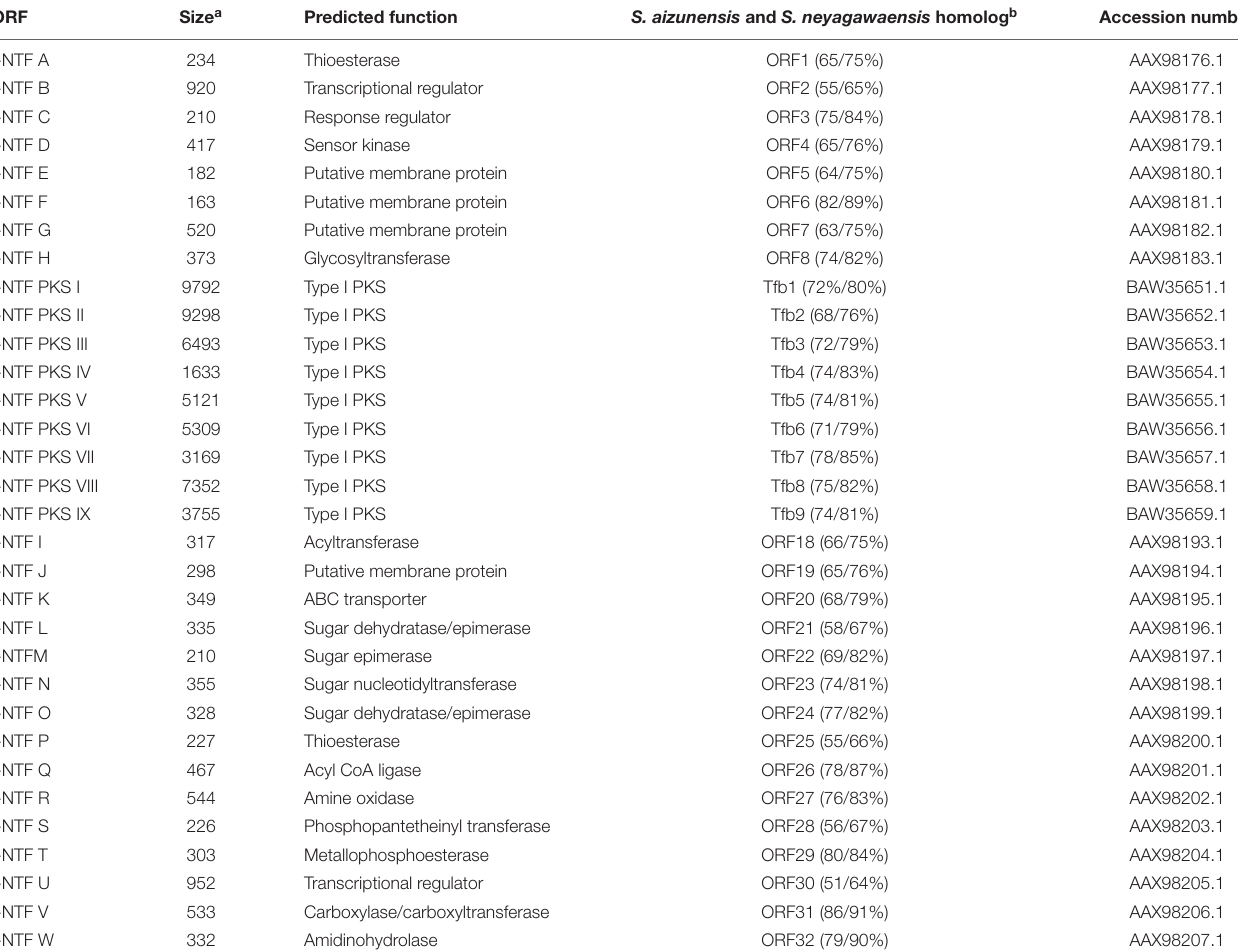
TABLE 2 | Annotation of the ORFs in the I-NTF gene cluster. ORF Size a Predicted function